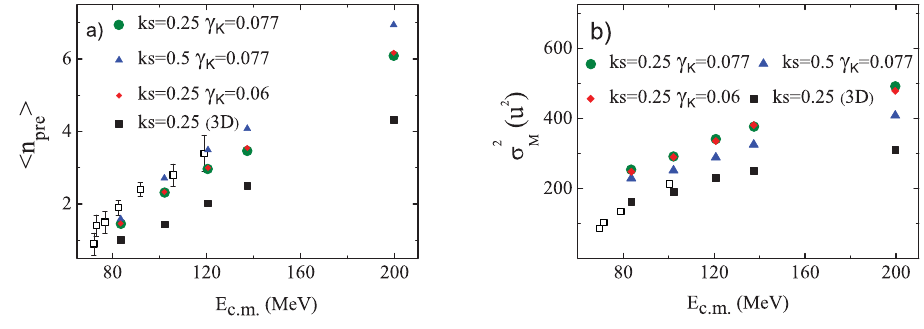
Figure 2. The calculated prescission neutron multiplicity (a) and variance of fission fragment mass distribution (b) are compared with experimental data [19, 20] for the 224 Th. The open symbols are experimental data, the filled circles are results of 4D calculations with k s = 0.25 and (cid:1) K = 0.077(MeVzs) − 1 / 2 , the filled triangles – results of 4D calculations with k s = 0.5 and (cid:1) K = 0.077(MeVzs) − 1 / 2 , the filled dimonds – results of 4D calculations with k